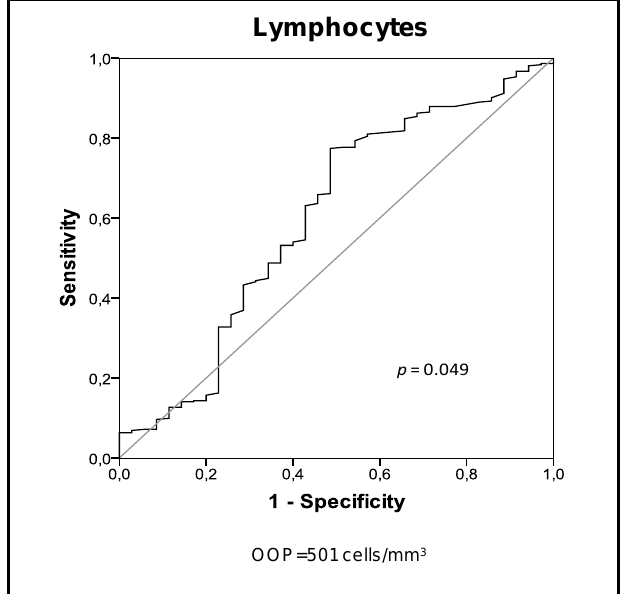
Figure 2. AUROC analysis for ICU mortality in sCAP patients with no septic shock.